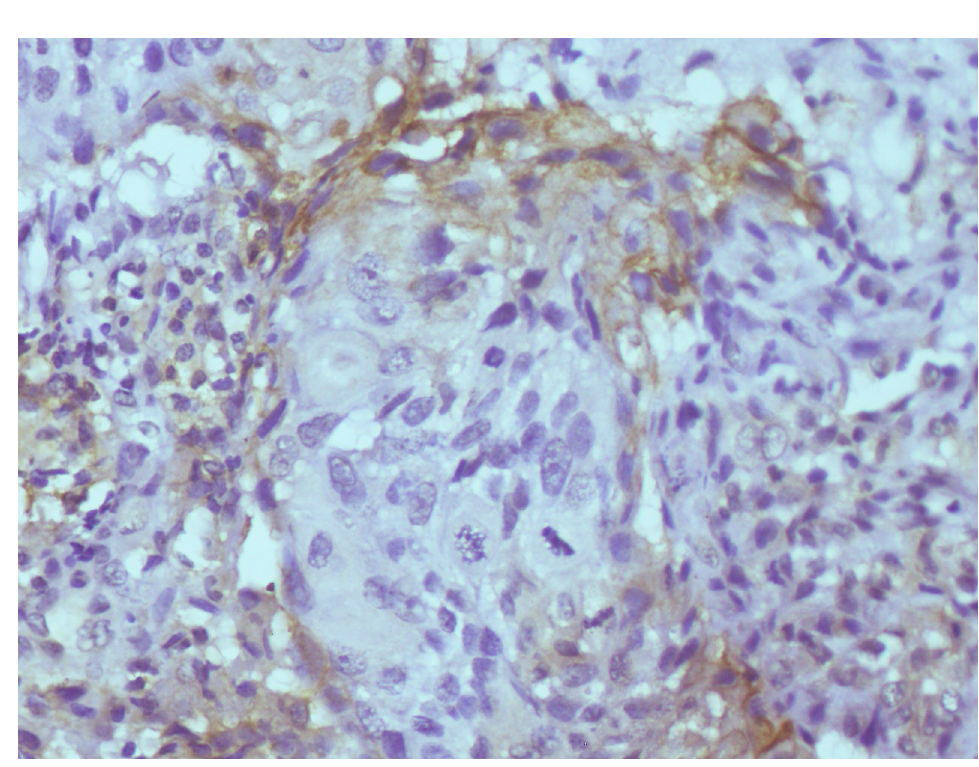
Fig 4. Photomicrograph showing marginal staining of nest of invasive squamous cell carcinoma (anti-PD-L1 Immunohistochemical stain, X100).